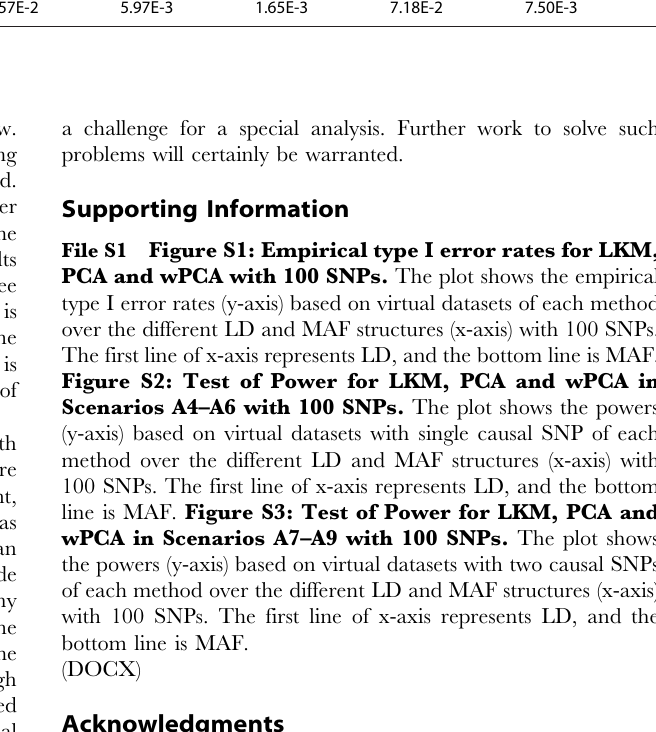
Individual SNP test